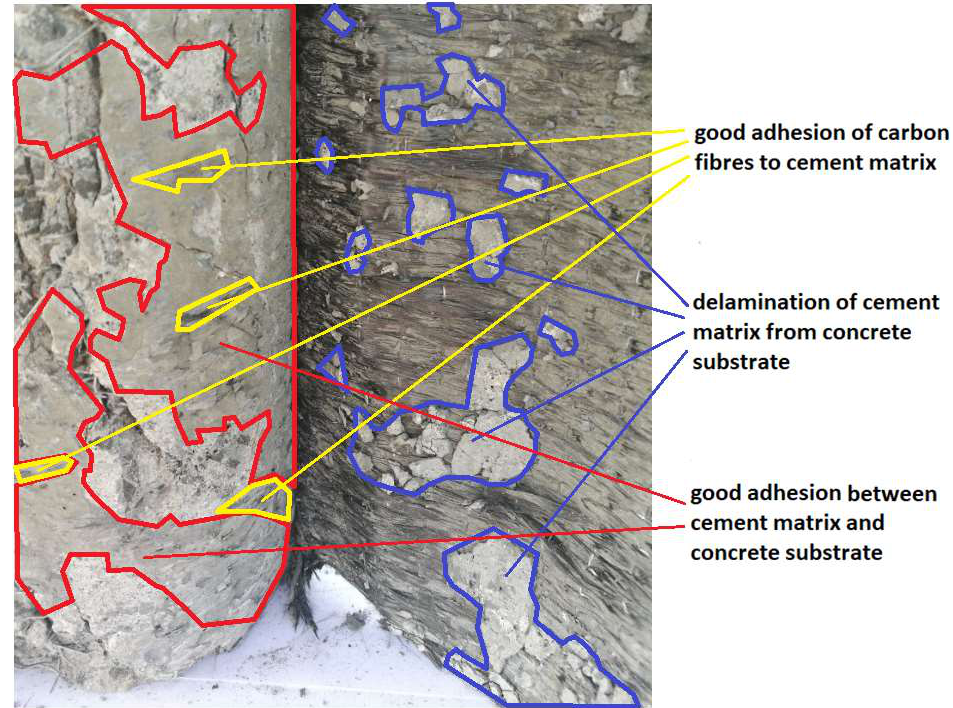
Figure 12. Analysis of the failure of the connection between the carbon fibers reinforced with the cement matrix and the grinded concrete surface.